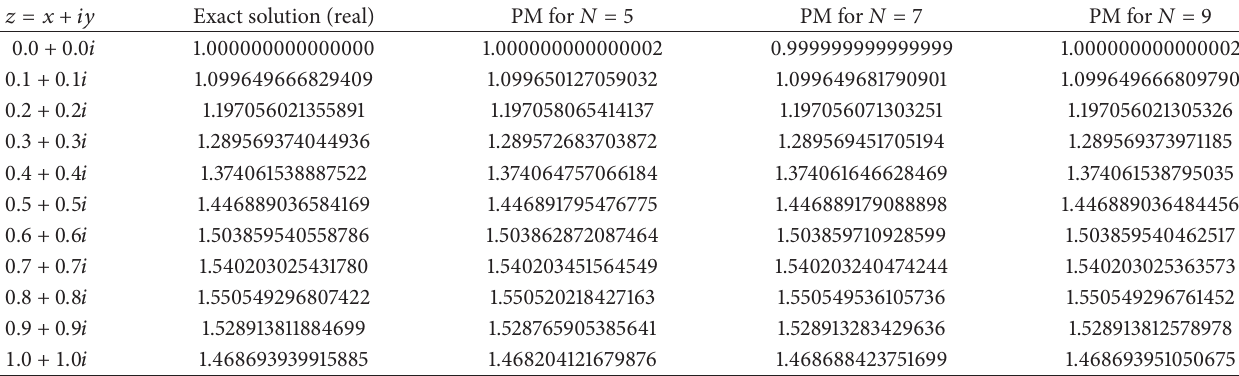
Table 1: Numerical results of Example 13, for Re ( exp (𝑧)) = exp (𝑥) cos (𝑦) .